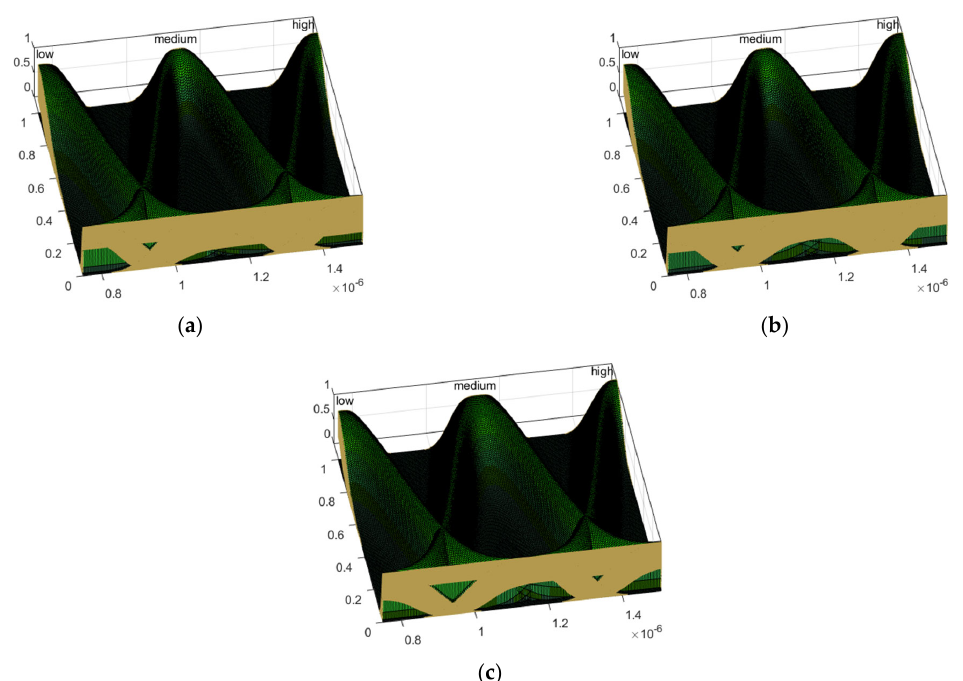
Figure 12. Best future prediction (Brazil).